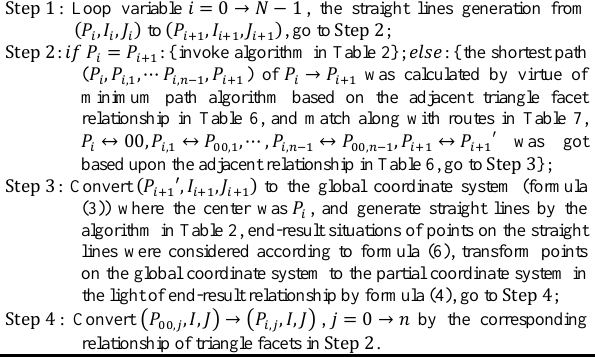
Table 8. The algorithm generation for arbitrary linear entity on the icosahedron surface.